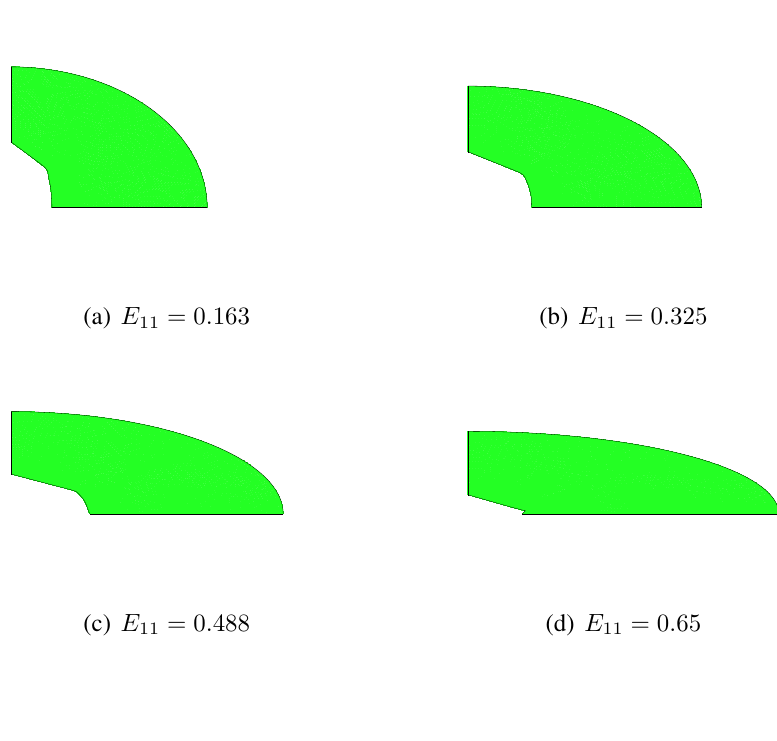
Figure 7 . f = 0 . 01 , λ = 3 . Microstructure evolution under k 0 0 the unit-cell